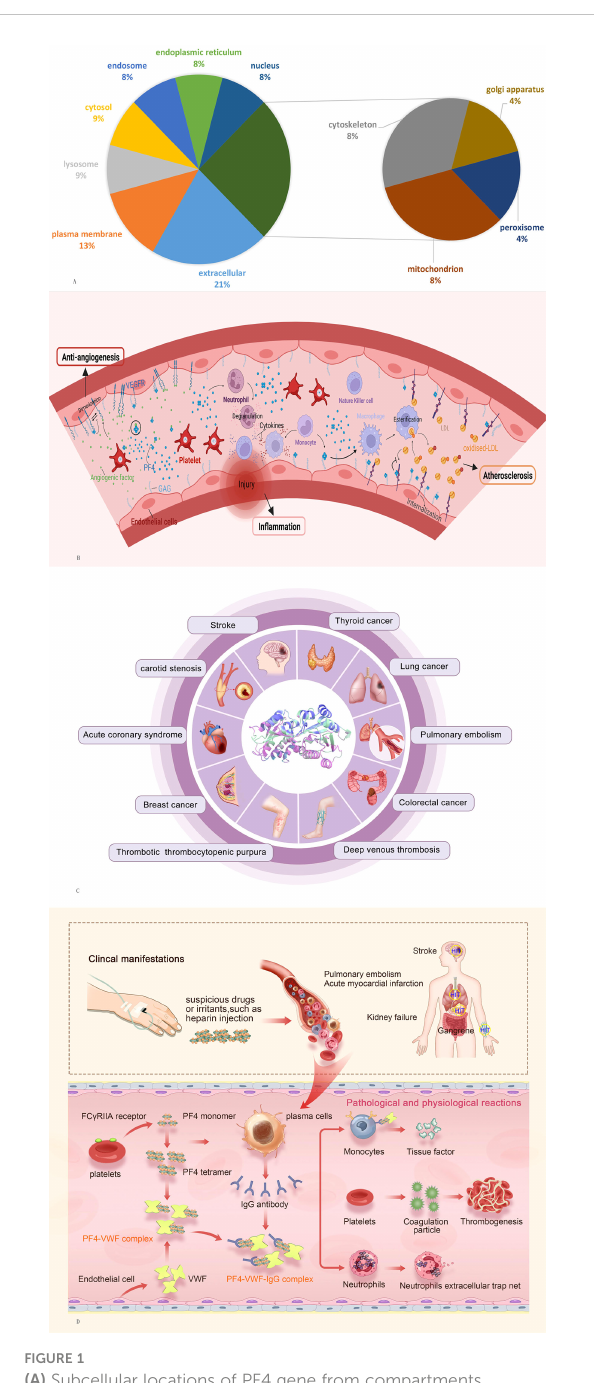
FIGURE 1 (A) Subcellular locations of PF4 gene from compartments. (B) Potential function of PF4 in antiangiogenesis, in fl ammation, and atherosclerosis. (C) Overview of systemic diseases involving VWF. (D) Potential mechanistic hypothesis of the PF4 – VWF complex in inducing and accelerating thrombosis. PF4, platelet factor 4; VWF, von Willebrand